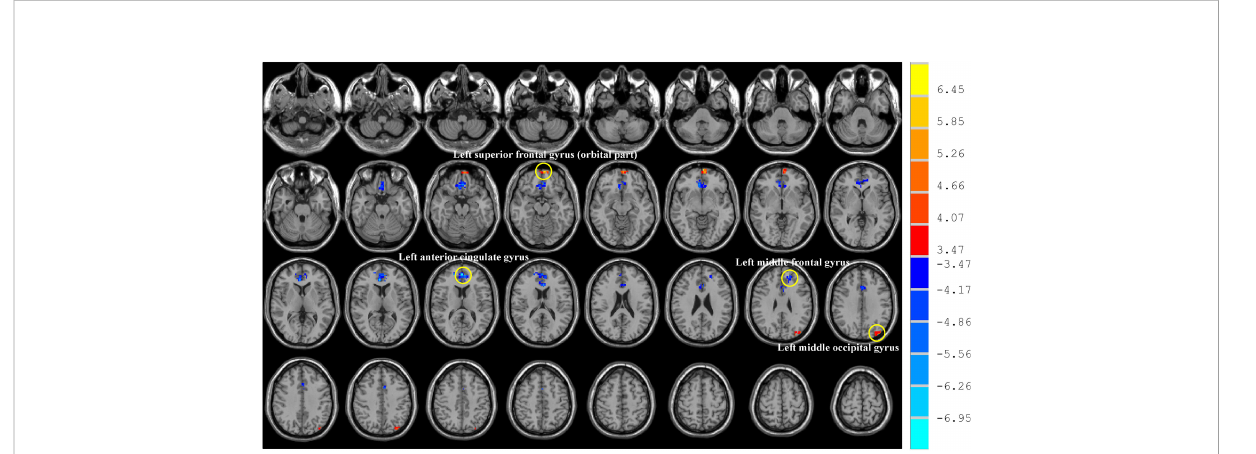
FIGURE 2 Brain regions showed altered fALFF in CRC patients. Post-treatment CRC patients showed decreased fALFF in the left anterior cingulate gyrus and middle frontal gyrus, while displaying increased fALFF in the left superior frontal gyrus (orbital part) and middle occipital gyrus. CRC: colorectal cancer. fALFF: fractional amplitude of low-frequency fl uctuation. The signi fi cance threshold was set at P <0.05 (voxel-level was set at P <0.001 and cluster-level was set at P <0.05; two tailed; the corresponding minimum cluster size was 21 voxels) for multiple comparisons using Gaussian Random Field (GRF) theory. Red indicated regions with increased fALFF while blue indicated regions with decreased fALFF.